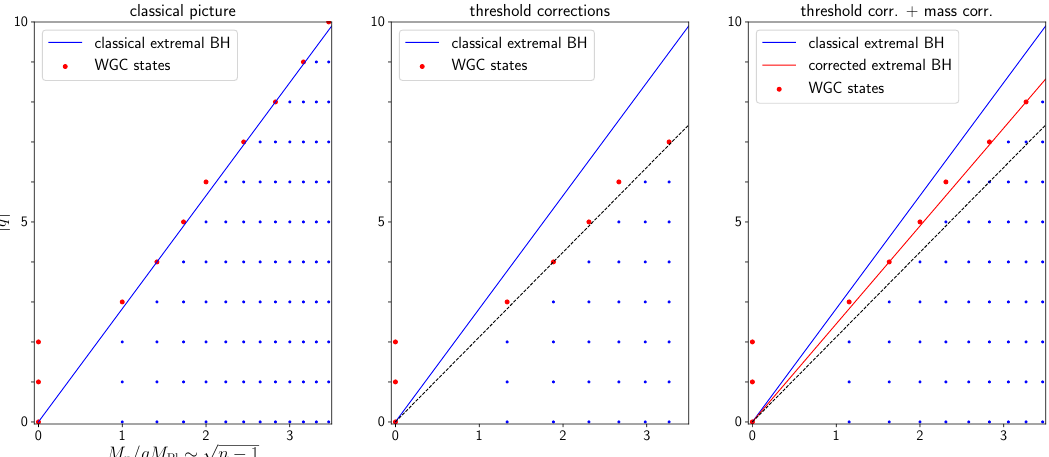
Figure 2 . Left: Neglecting corrections away from the in(cid:12)nite distance point the (sub-)lattice WGC is ful(cid:12)lled by a (super-)extremal tower of heterotic string excitations. Center: The gauge coupling is corrected away from the in(cid:12)nite distance point such that the former WGC states do not marginally lie above the classical bound (here, they lie below, as in the example of section 5.2.). Right: Taking into account corrections to the relation M 2 nT str the tower of formerly extremal states satis(cid:12)es n (cid:24) the repulsive force condition F Coulomb F Grav + F Yuk although it is still sub-extremal with j j (cid:21) j j j j respect to the classical extremality bound. We expect corrections to black hole solutions to be such that (super-)extremality of the string states is restored (red line).